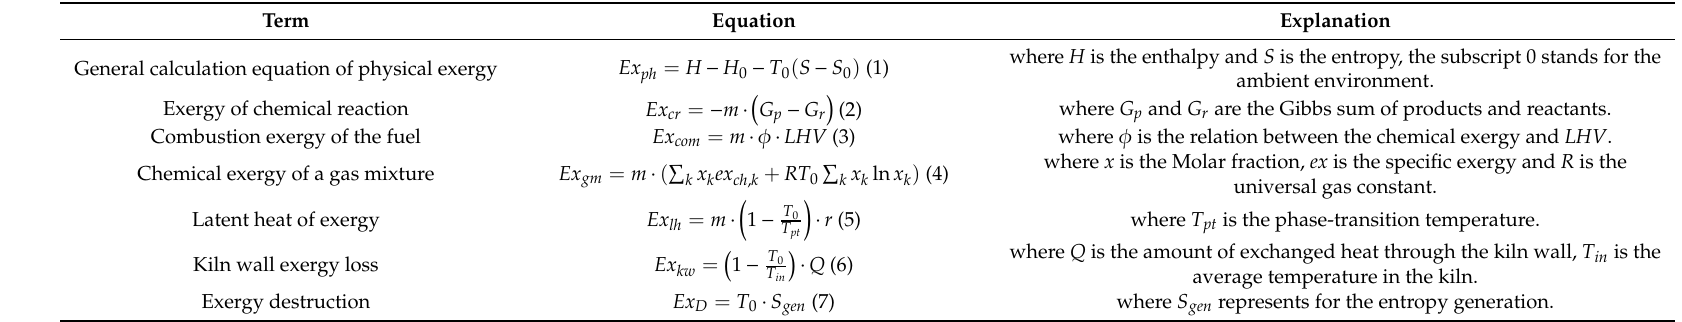
Table 3. Equations used in exergy